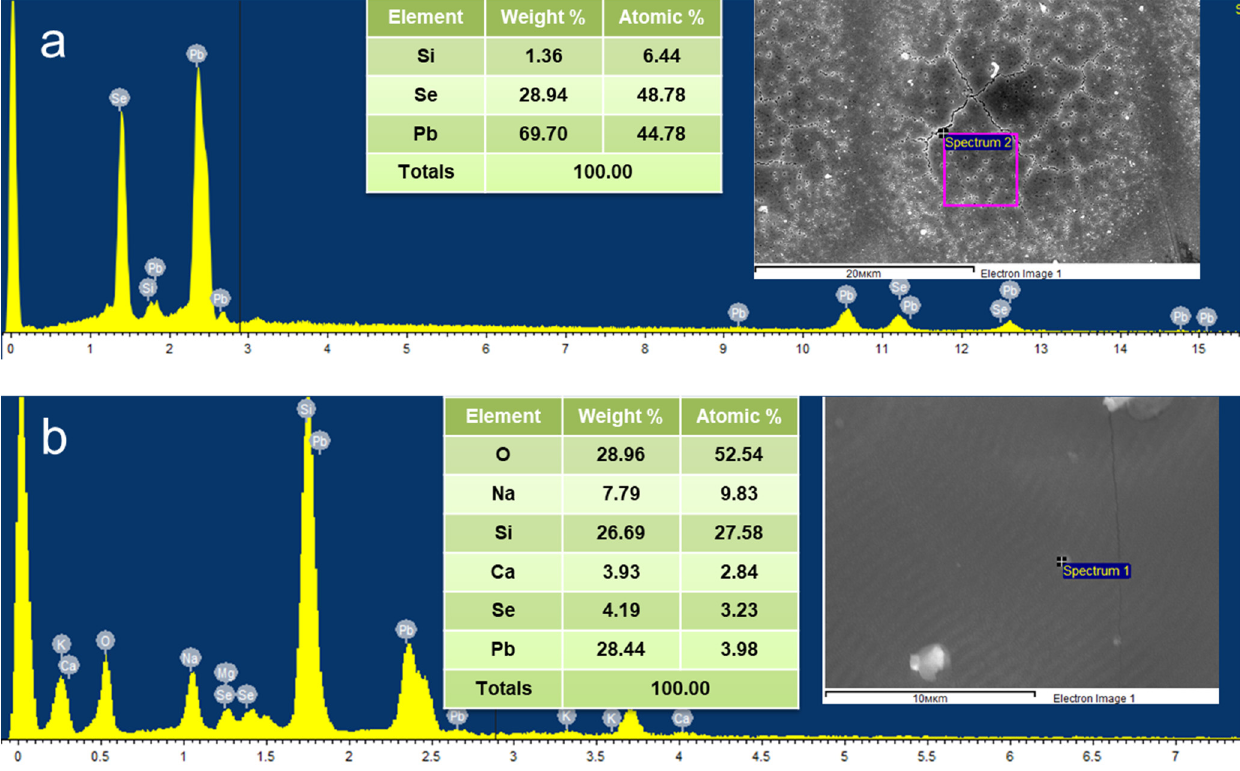
Figure 8. FESEM-EDX image: ( a ) darkening mode with CW modification, ( b ) bleaching mode with CW modification.